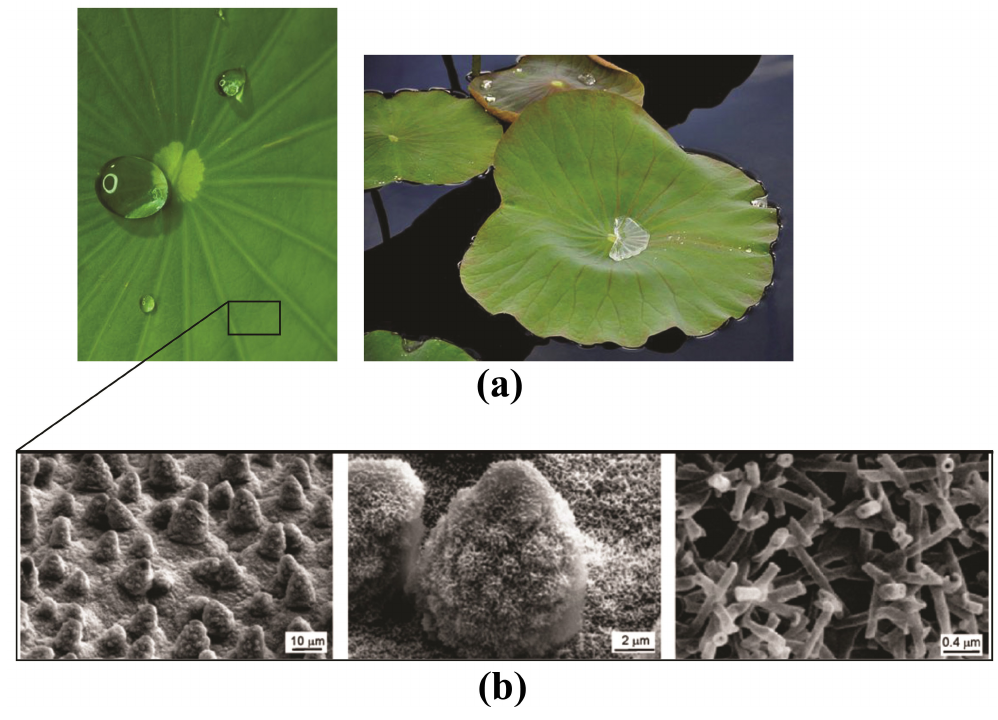
Figure 1. Lotus leaf. ( a ) Zero magnification; from websites [34,35]. ( b ) Three different magnification of scanning electron microscope (SEM) images showing morphological micro- and nanostructures; from Koch et al. [33].